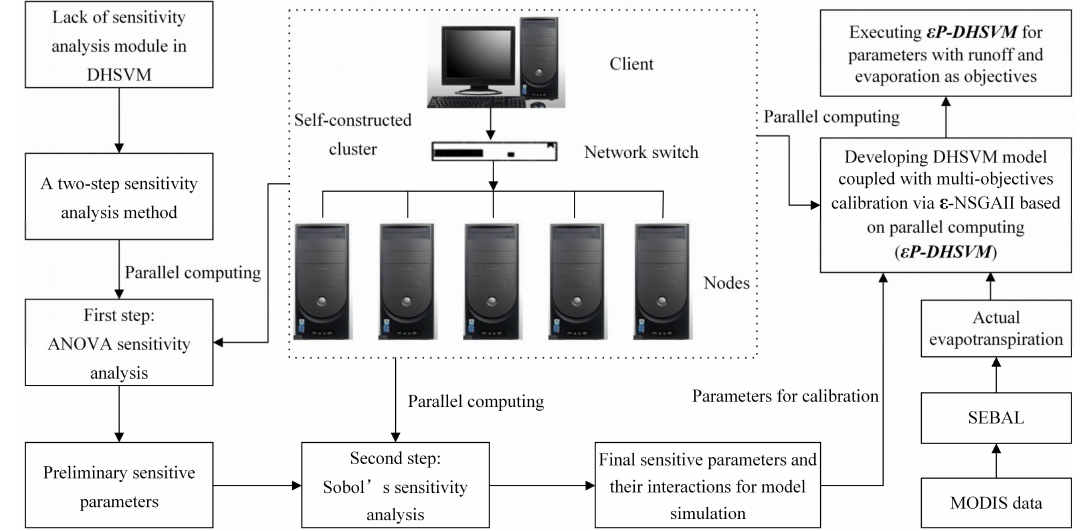
Figure 2. General framework used in the